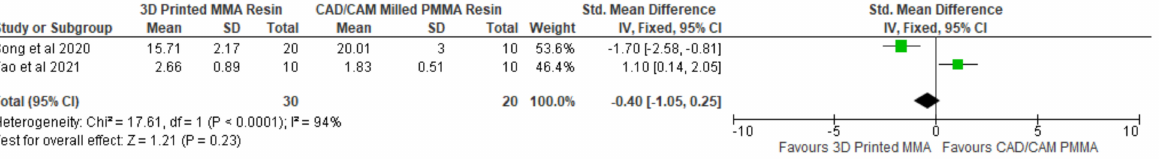
Figure 2. Forest plot comparing color change between 3D-Printed MMA Resin and CAD/CAM milled PMMA